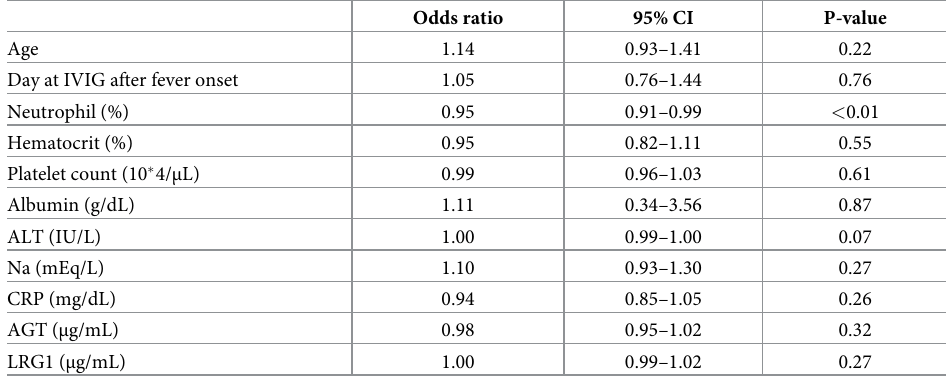
Table 4. Multivariable analysis of clinical and laboratory data in relation to IVIG